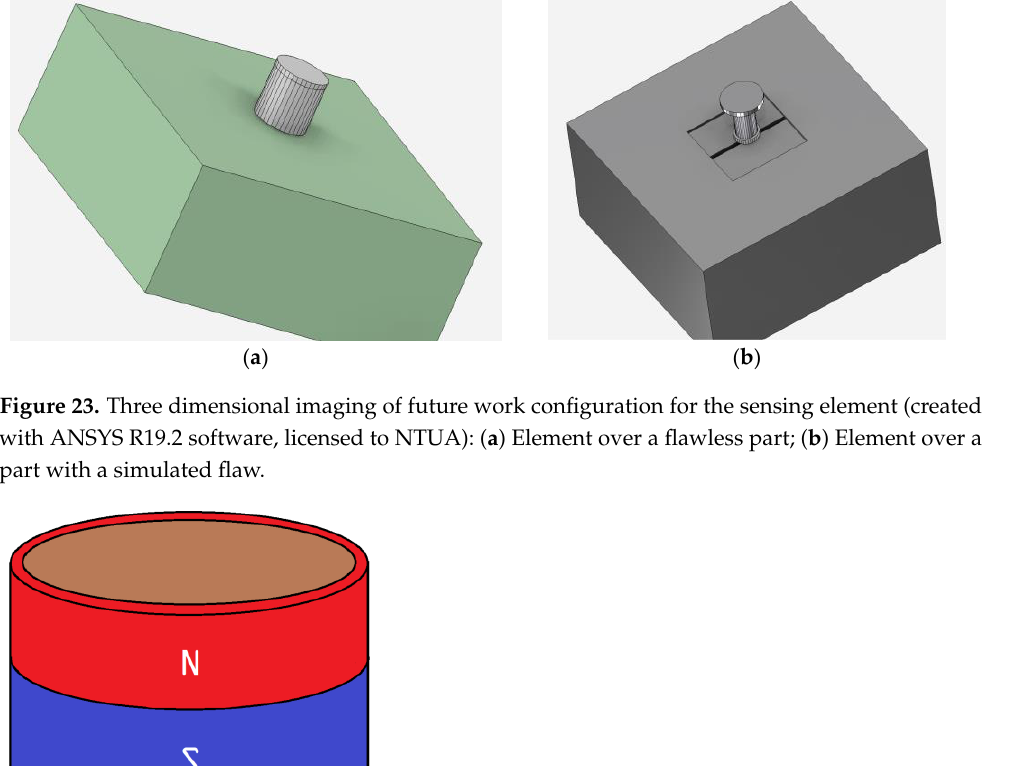
Figure 24. Shape of a permanent magnet.